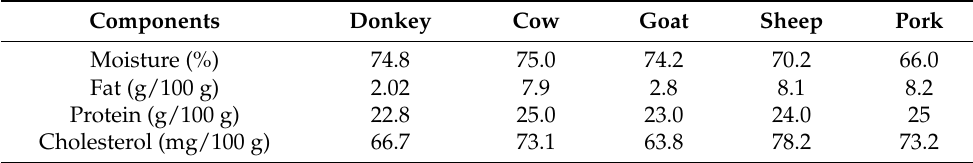
Table 2. Nutritional composition of meat from donkey and other species. Components Donkey Cow Goat Sheep Pork